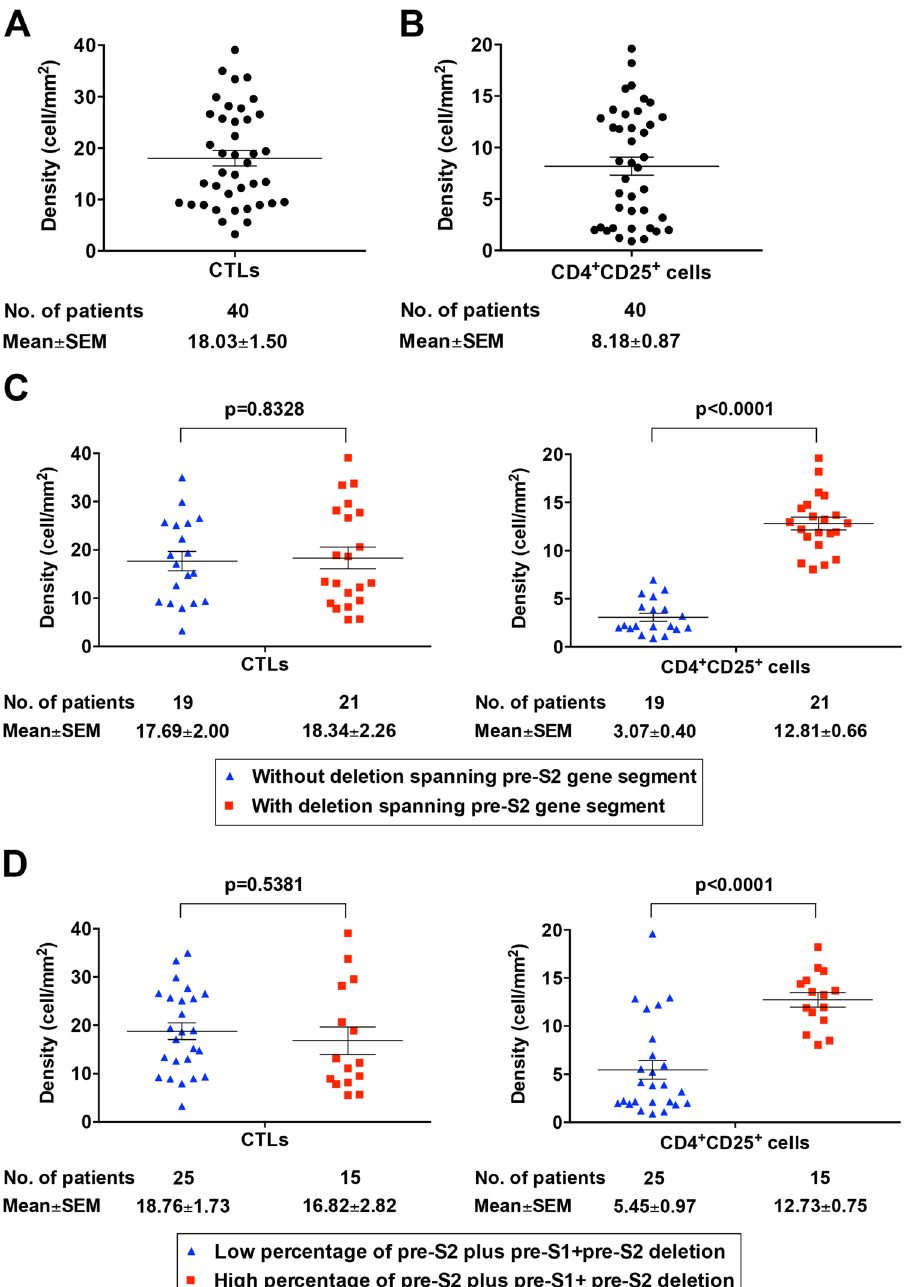
Figure 3. Pre-S2 mutant-positive patients exhibited a significantly higher density of CD4 + CD25 + cells but similar CTLs in HCC tissues. ( A ) Density of CTLs in HCC tissues of total patients. ( B ) Density of CD4 + CD25 + cells in HCC tissues of total patients. ( C ) Density of CTLs (left graph) and CD4 + CD25 + cells (right graph) in HCC tissues of patients with and without deletion spanning pre-S2 gene segment. ( D ) Density of CTLs (left graph) and CD4 + CD25 + cells (right graph) in HCC tissues of patients with high and low percentage of pre-S2 plus pre-S1 + pre-S2 deletion. Horizontal lines represented the mean values of the distribution. A P value < 0.05 was considered statistically